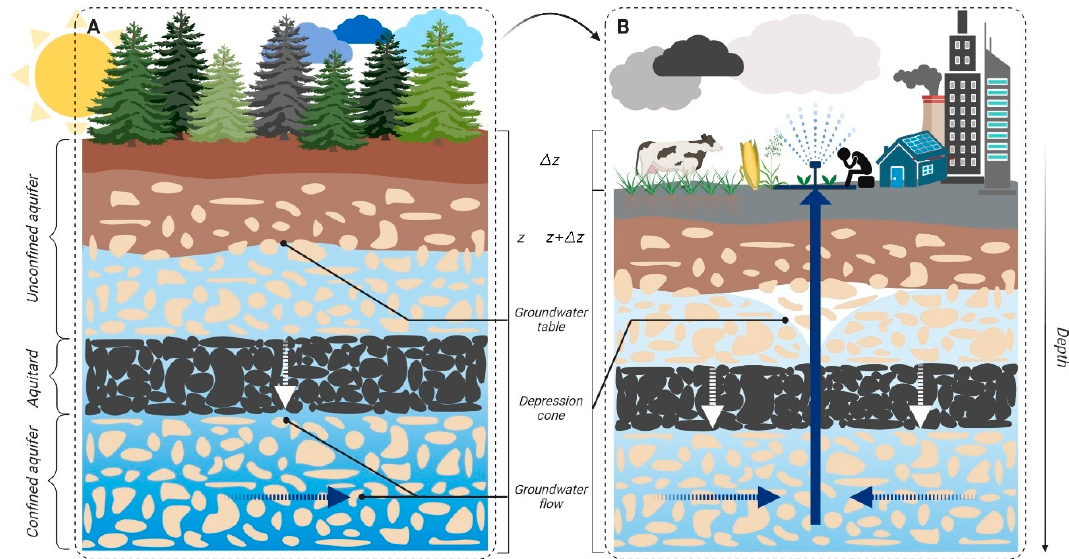
Figure 4. Schematic vertical cross-section of the groundwater system containing relatively coarse- (aquifers) and fine-grained (aquitard) deposits; ( A ) original hydrodynamic equilibrium; ( B ) disruption of the initial hydrodynamic balance as a consequence of groundwater pumping; lowering of the groundwater table and compaction of the compressible aquifer resulting in land subsidence.